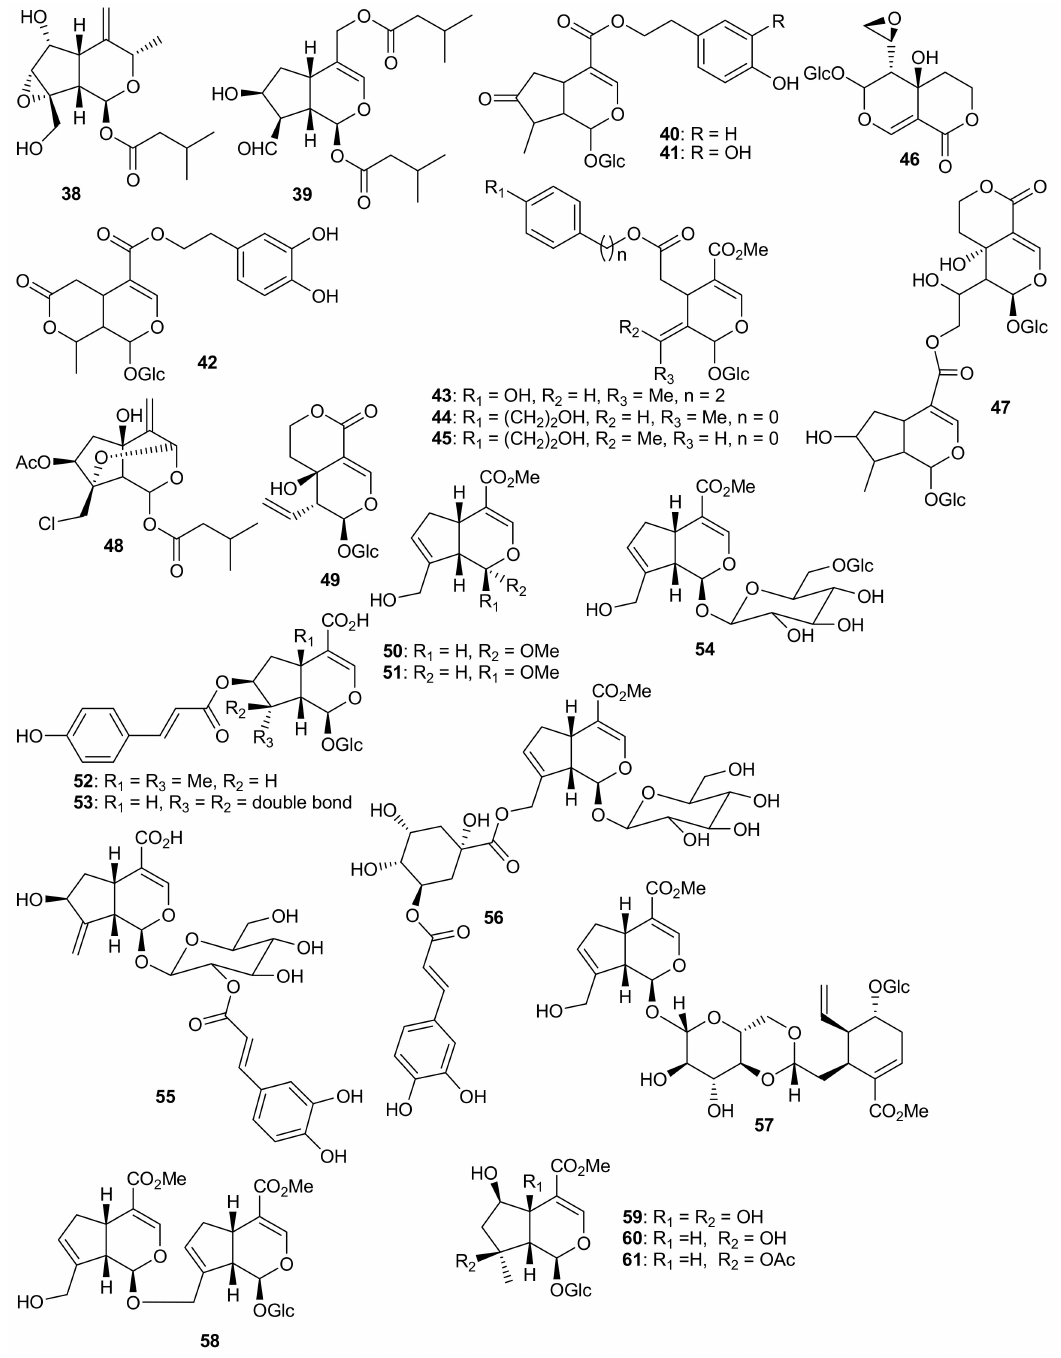
Figure 7. Structures of iridoids 38 – 61